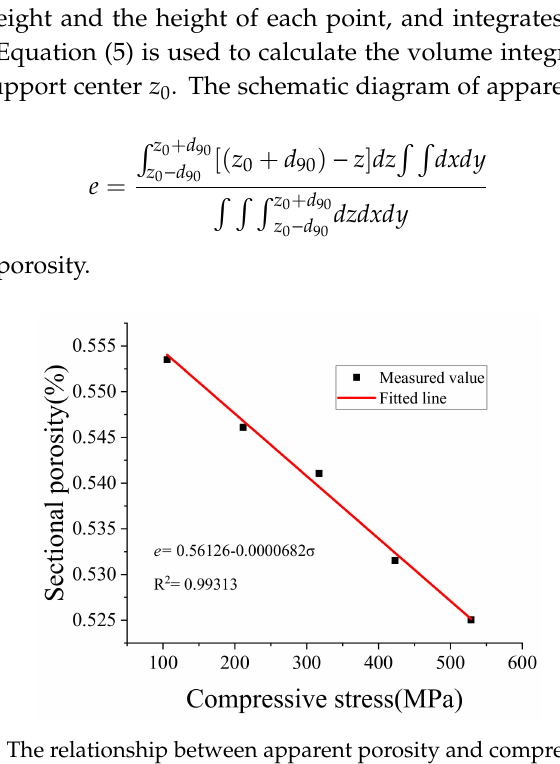
Figure 14. The relationship between apparent porosity and compressive stress.